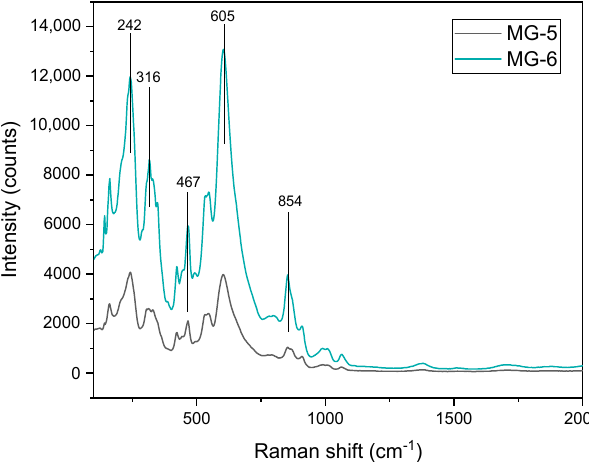
Figure 6. Raman spectra of MG-5 and MG-6.